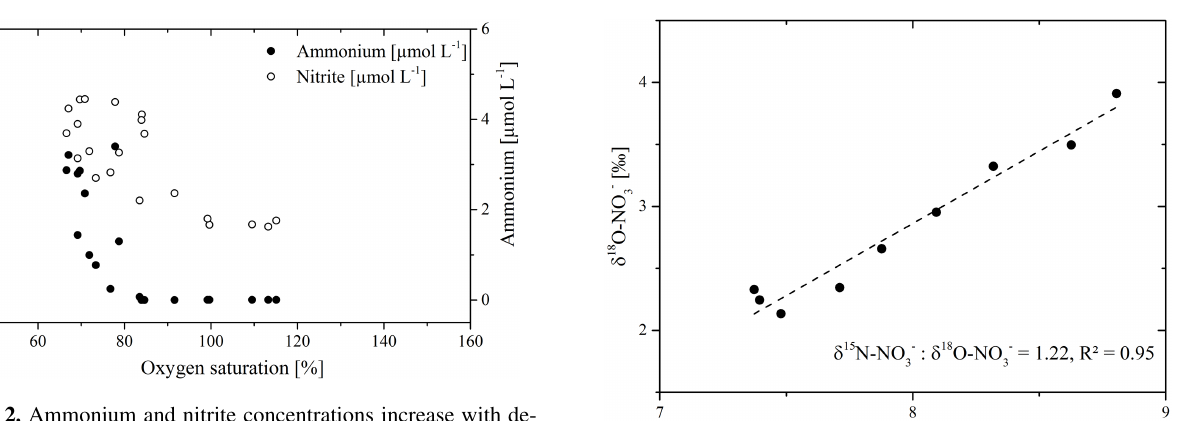
Figure 2. Ammonium and nitrite concentrations increase with de- creasing dissolved oxygen saturation.